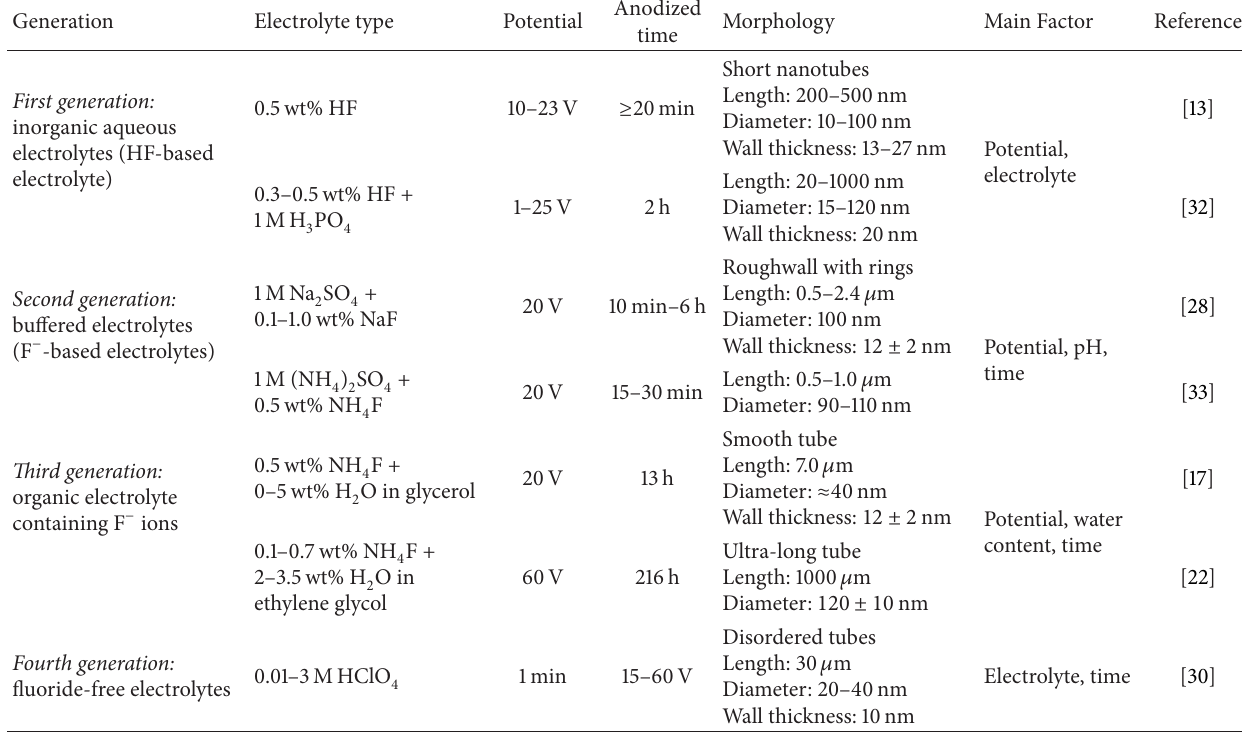
Table 1: Brief summary ofvarious synthesis generations of